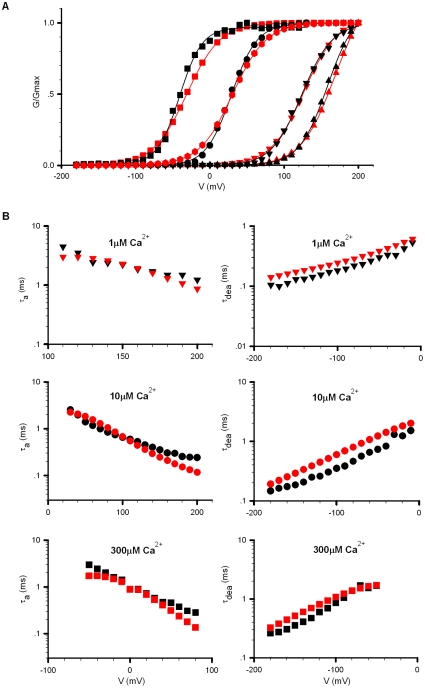
Comparison of kinetic characteristics between simulation data and target data.(A) The G-V curves of BK channels were plotted for data and best-fit, in the presence of 1, 10 and 300 µM Ca2+, respectively. (B) Time constants of activation (Left) and deactivation (Right) of BK channels were plotted for data and best-fit, in the presence of 1, 10 and 300 µM Ca2+, respectively. Here data are in black and fits in red.